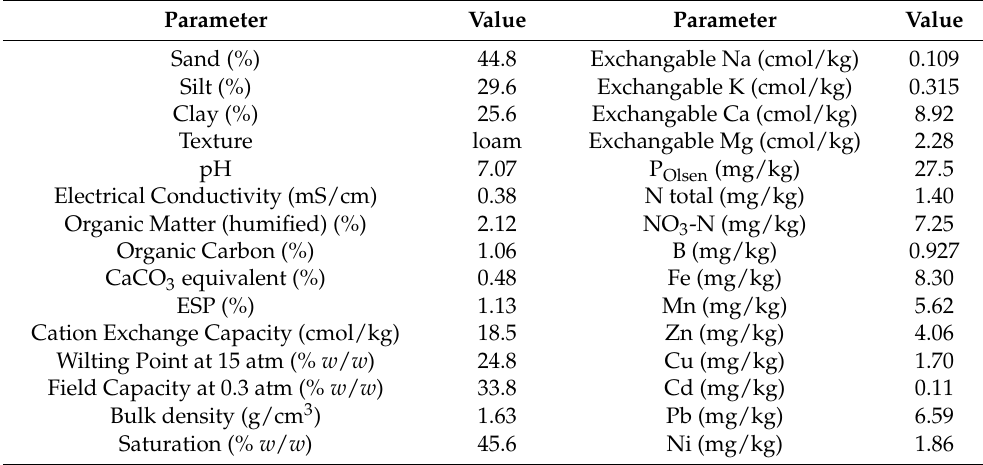
Table 2. Main physicochemical characteristics of the agricultural soil z . Parameter